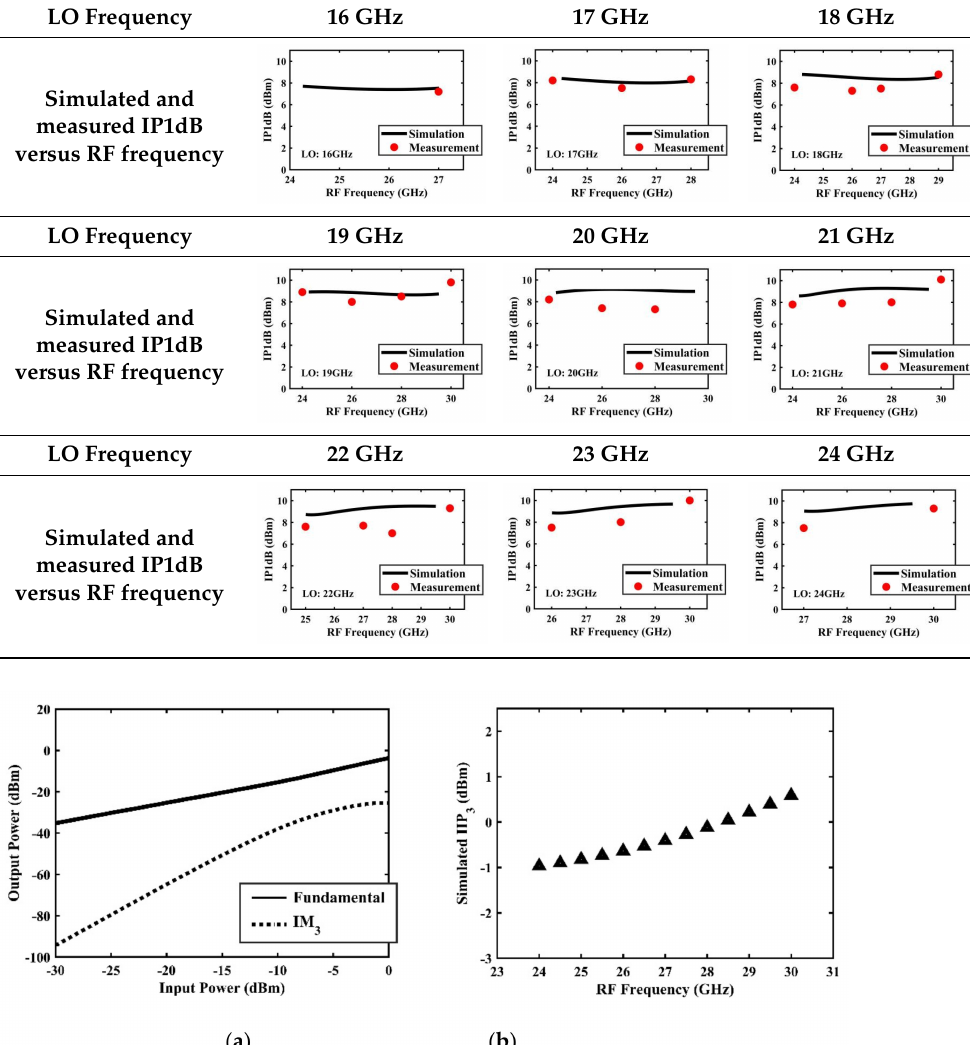
Figure 17. ( a ) Simulated curves of fundamental and 3rd order product, ( b ) simulated IIP 3 versus RF